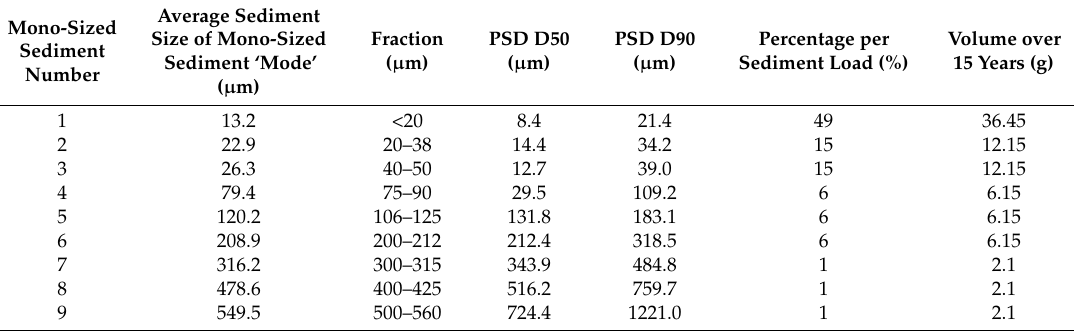
Table 1. The mono-sized sediment fractions based on the Adelaide clay soils (PSD = Particle Size